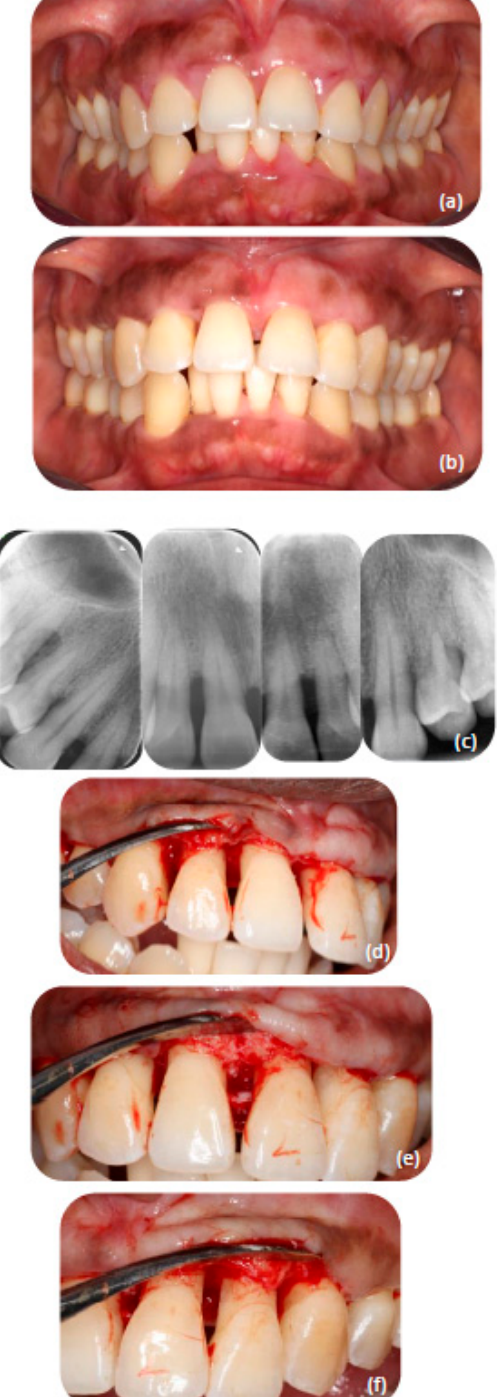
Figure 2. ( a ) Intraoral view at intake. ( b ) Intraoral view at 6 months after initial non-surgical treatment. ( c ) Radiographic overview of the maxillary anterior area. ( d – f ) Intraoral view during surgery.